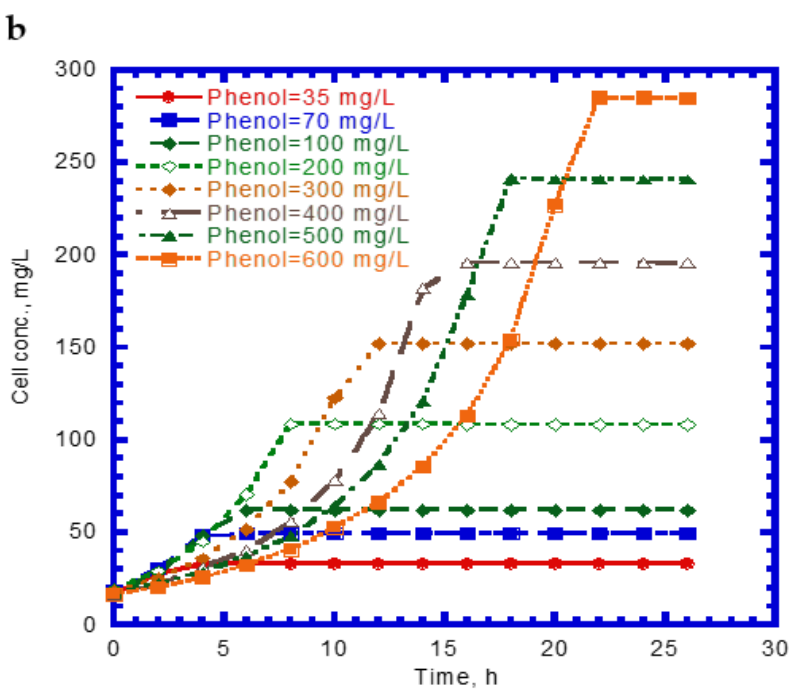
Figure 1. Single phenol biodegradation by P. putida at various initial phenol concentrations: ( a ) phenol biodegradation and ( b ) cell growth.